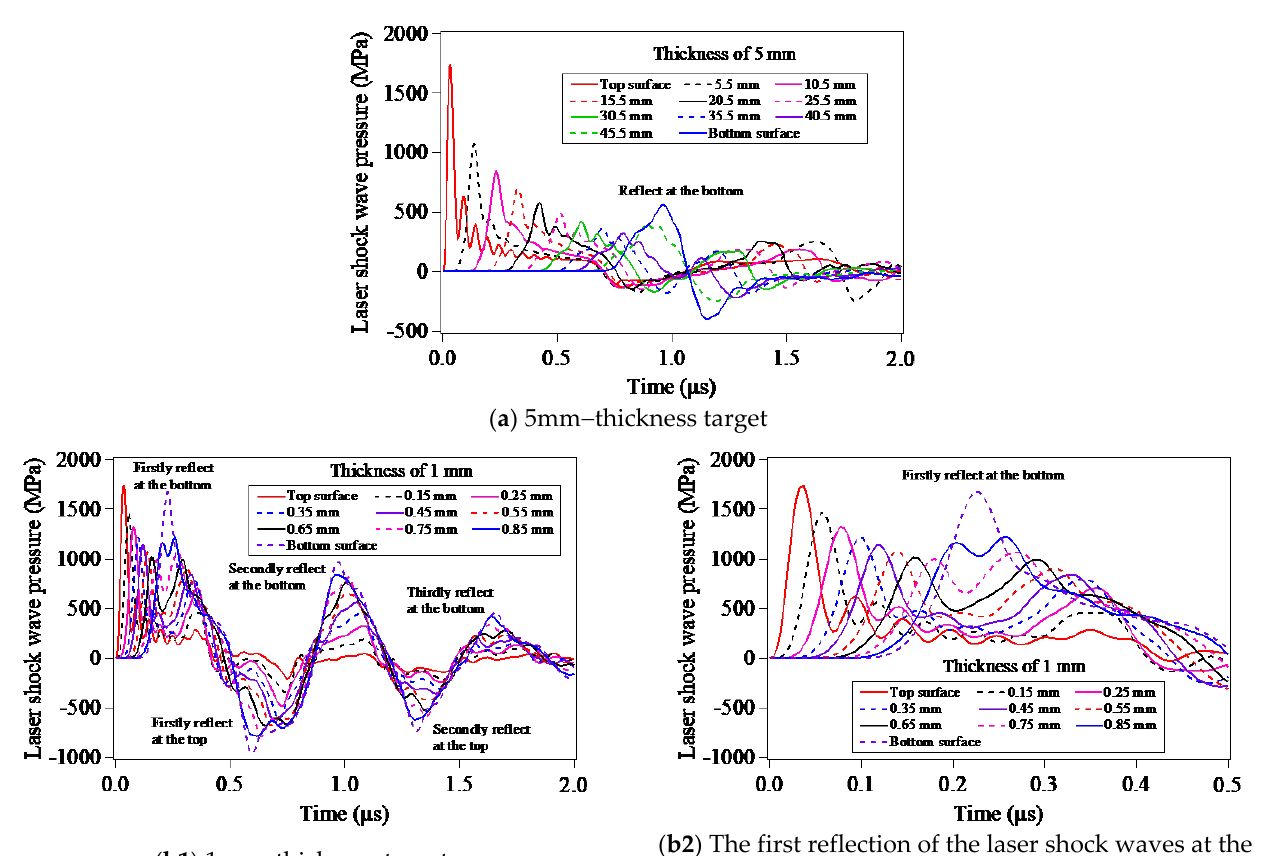
Figure 10. Propagation, attenuation and reflection of the LSP − induced shock waves in the target models: ( a ) 5 mm − thickness target model; ( b ) 1 mm − thickness target model.